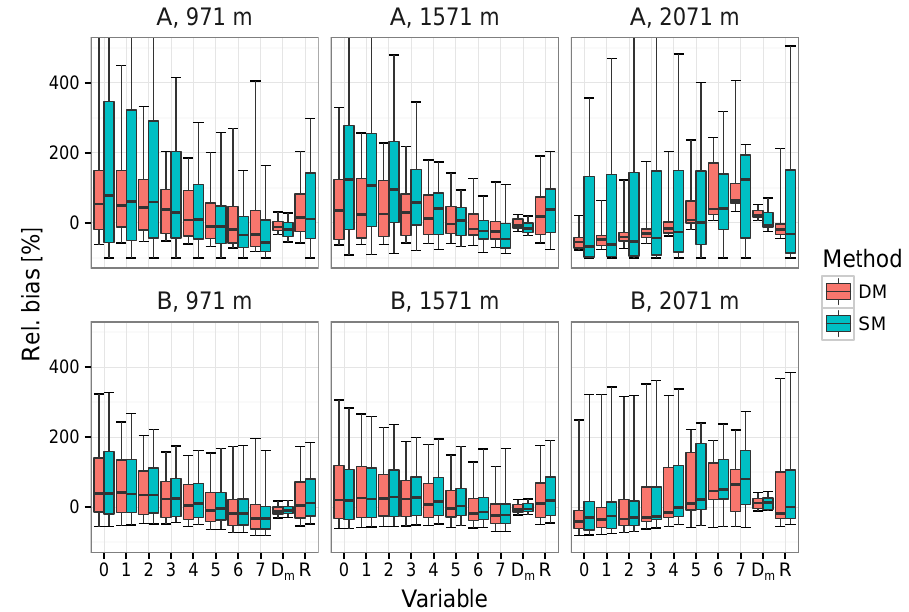
Figure 5. Distributions of relative bias on DSD moments zero to seven, comparing DSDs retrieved using PPI data to those measured by the MRR at Pradel Grainage. The results are classed by altitude for a selection of three altitudes across the compared range. Two comparisons are shown: in comparison A, SCOP-ME used raw PPI data and the double-moment technique used the noise-corrected version of the same data set. In B, both techniques used noise-corrected data sets. Variables and symbols as for Fig. 2. Input data for comparison A excluded records with negative or zero K dp or Z DR , while the noise-correction technique deals with these values and they were included in comparison B.